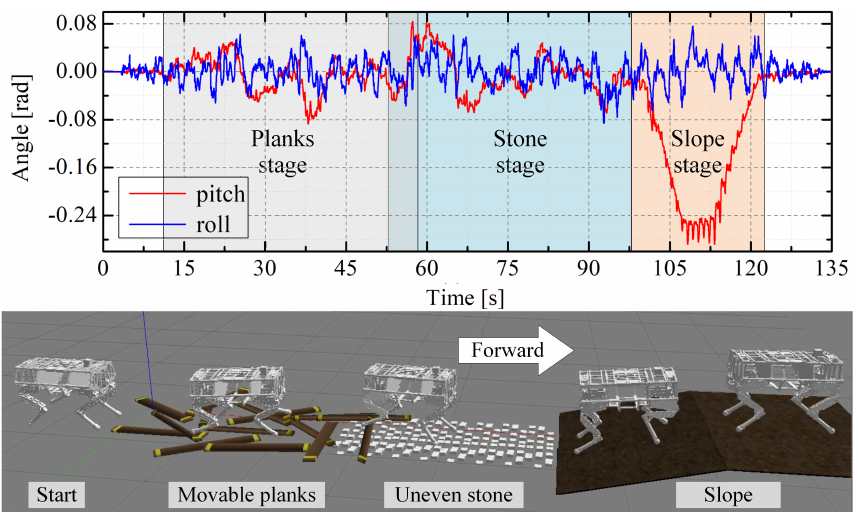
Figure 10. Simulation results of the quadruped robot traversing over three different terrains. The up- per figure demonstrates the snapshot of the quadruped robot traversing over three on complex terrains. The low figure shows the results of pitch (red line) and roll (blue line) angle profiles of the torso during walking.